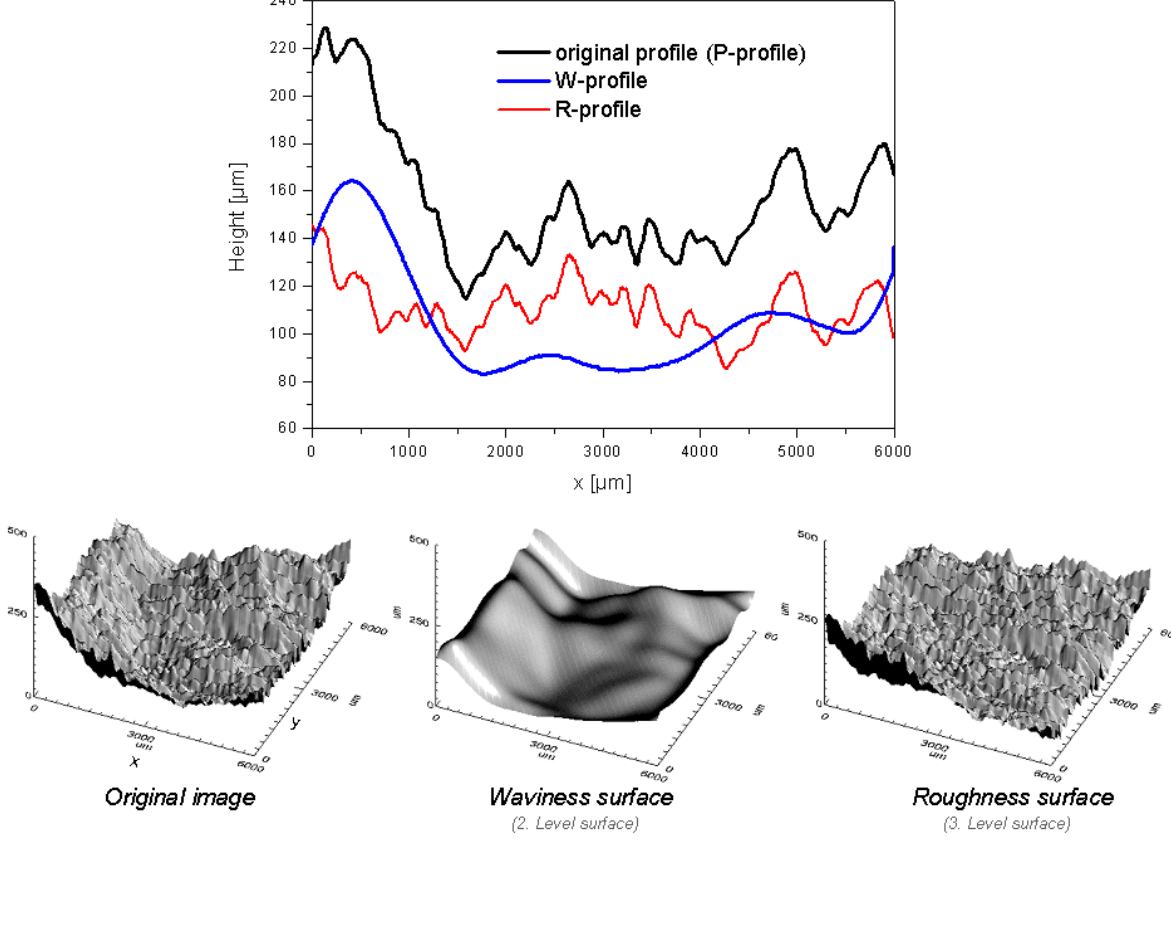
Figure 3. Above: W-profile and R-profile obtained applying FFT-filtering (original profile at y = 3,000 µm of the original image below). Below: waviness and roughness surfaces obtained applying FFT- filtering to the original topographic